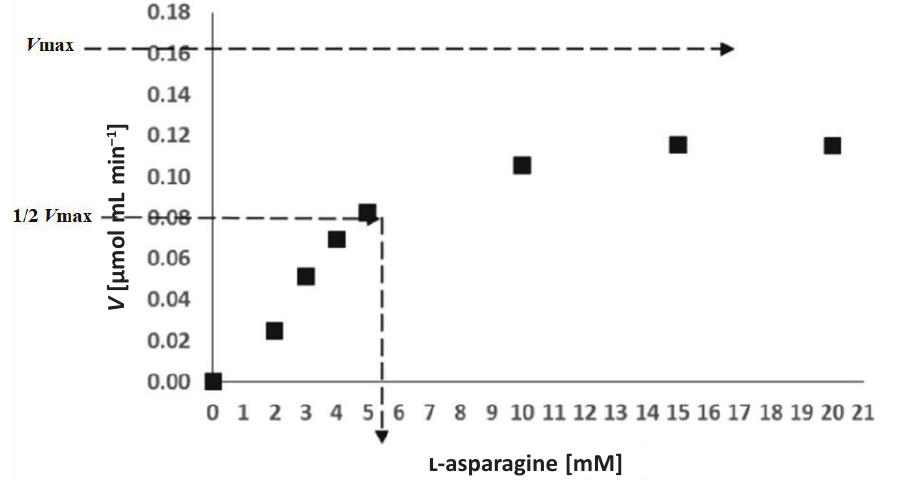
Fig. 1 – Michaelis-Menten kinetics of l -asparaginase from Enterobacter sp. strain M55